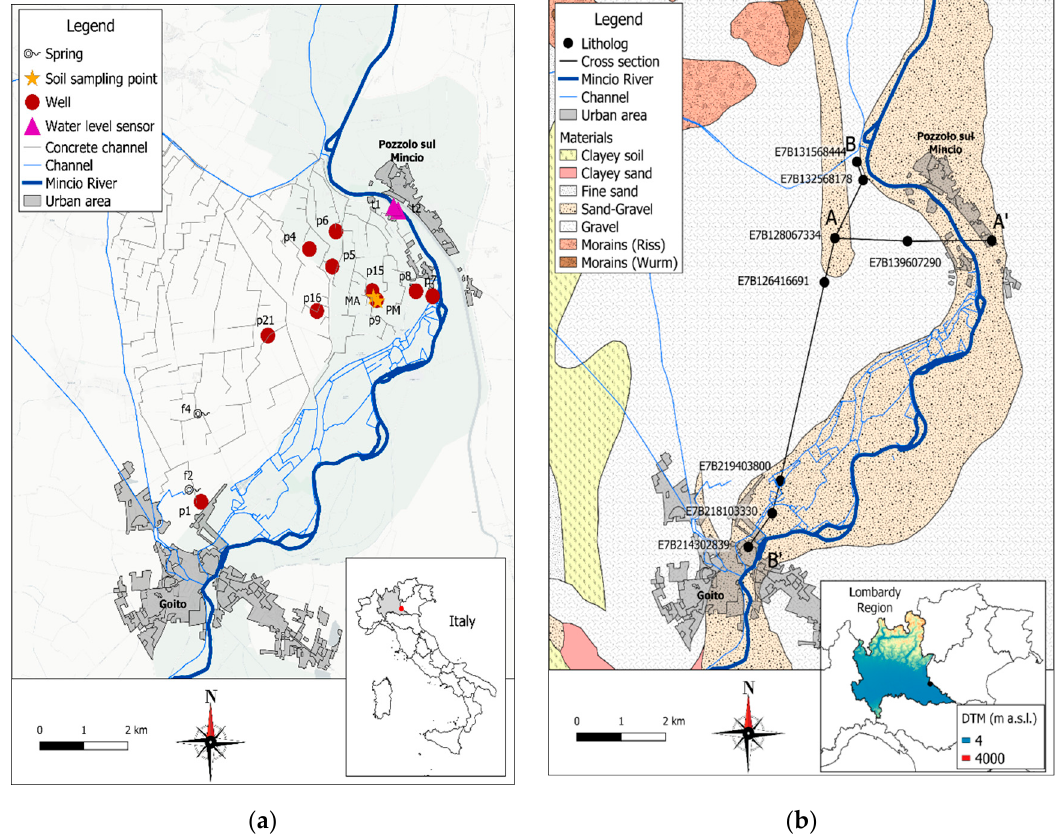
Figure 1. Schematic map of the study area ( a ) Location of monitoring and sampling points; ( b ) Geological map with digital terrain model of the Lombardy Region. AA’ and BB’ indicate the cross-sections.